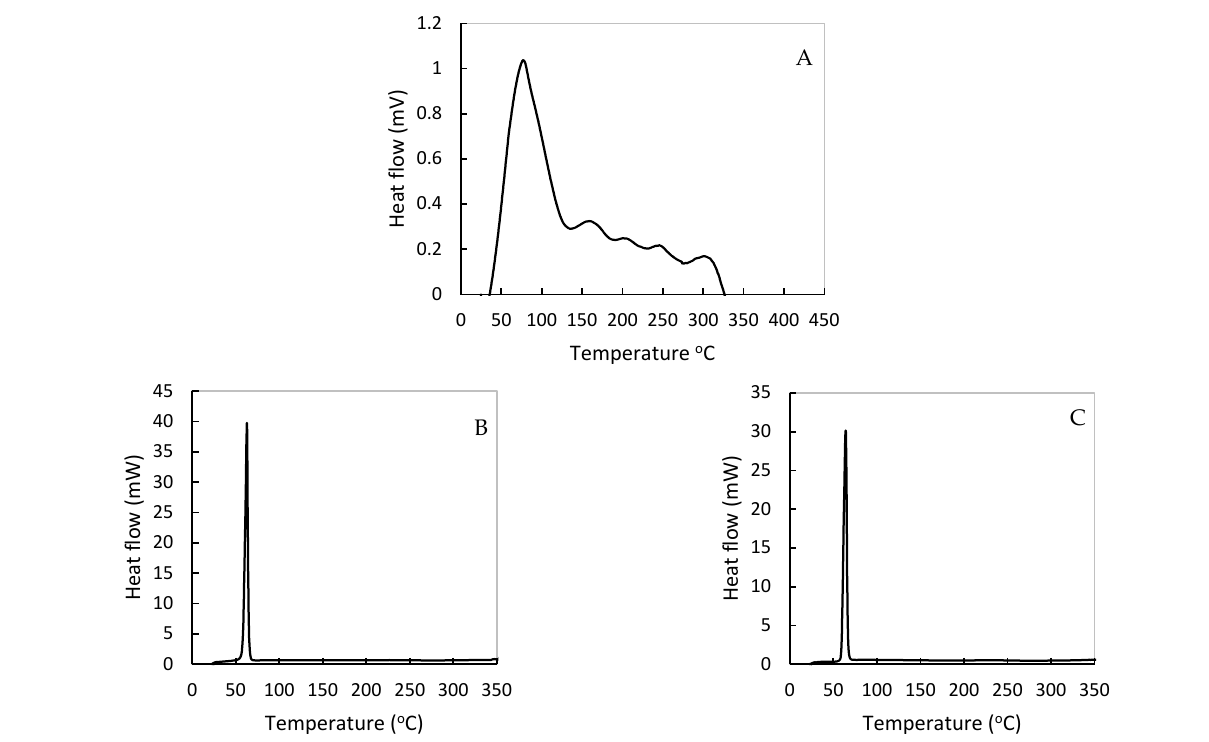
Figure 4. DSC thermograms of ( A ) MOLP ( B ) PEG4000 ( C ) PEG6000. Solid dispersion thermograms in Figure 5 exhibited characteristic and single endo ‐ thermic peaks with melting temperatures ranging from 57.76–61.76 °C and heat enthalpy ( ∆ H) ranging from 75.22–108.44 J/g. Sharp with slightly broadened base endothermic peaks were obtained for all the solid dispersions, thus, proving their semi ‐ crystallinity to amorphic. The characteristic endothermic peak corresponding to the carriers melting point (60–63 °C) was broadened and shifted toward lower temperature, with reduced in ‐ tensity, in all the solid dispersion. This could be attributed to the uniform distribution of